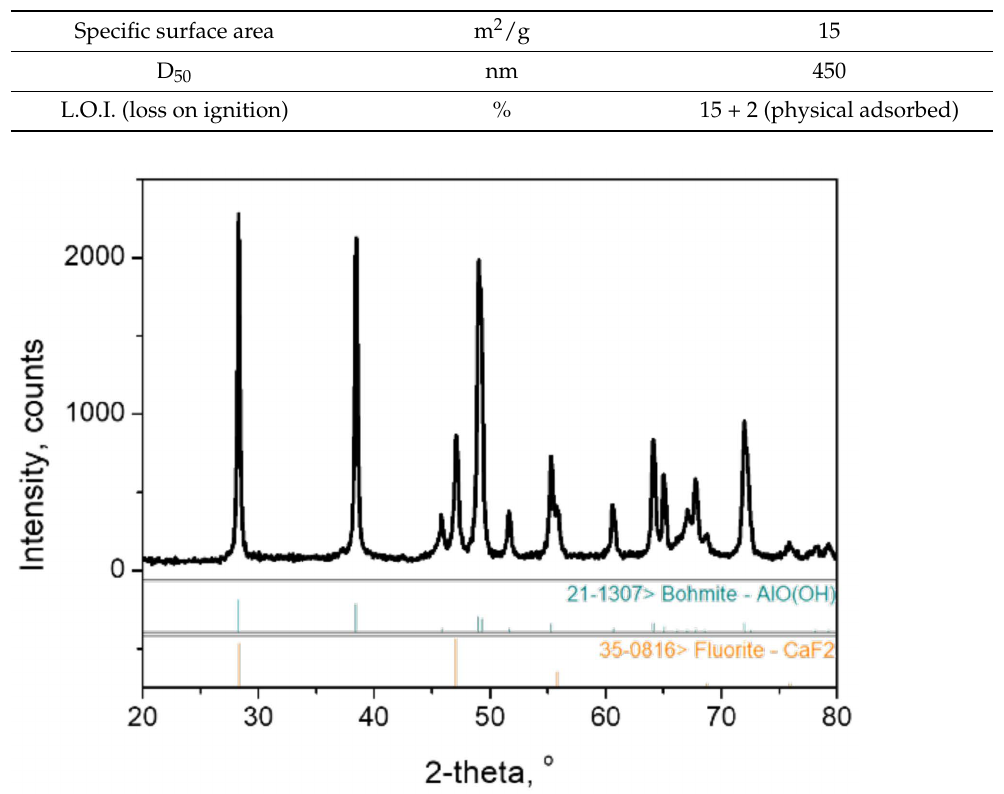
Table 2. Basic properties and characteristics of the starting boehmite powder.